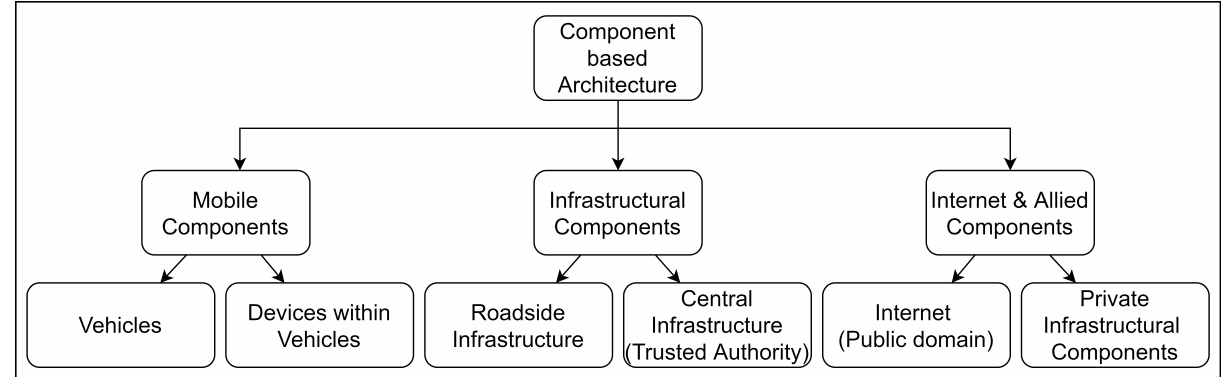
Figure 3. Component-based architecture of